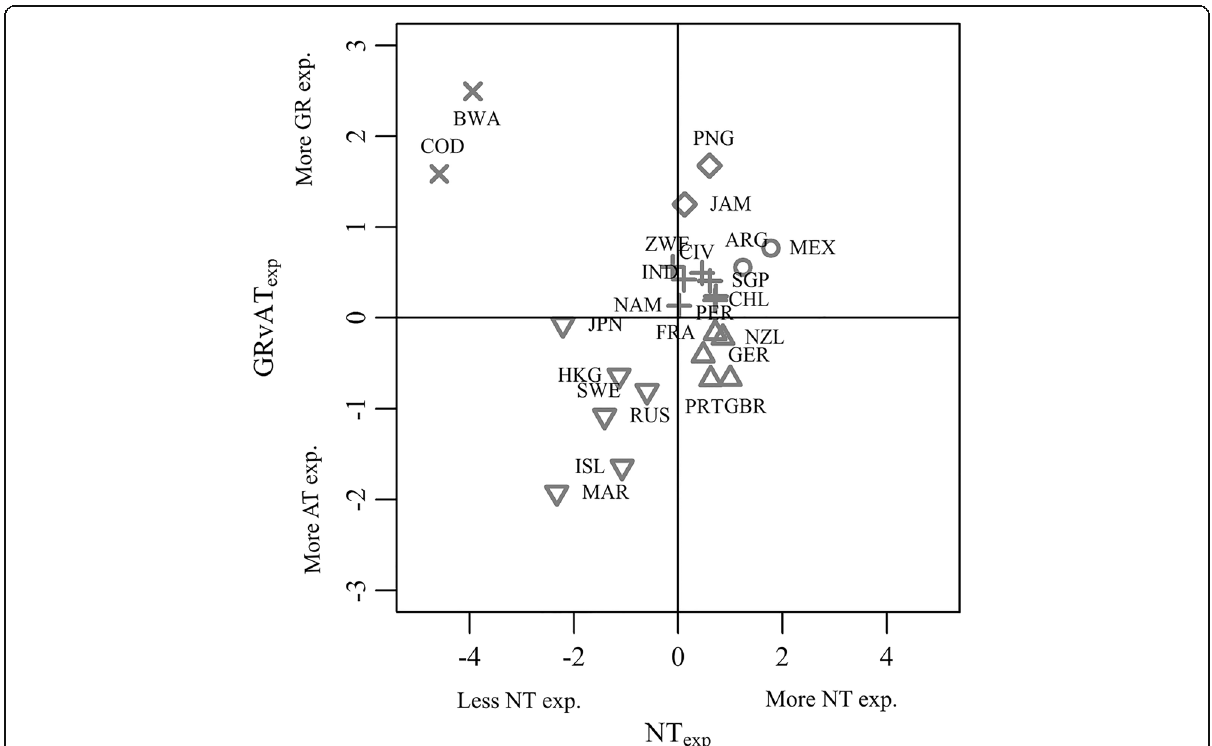
Fig. 2 Mean principal component scores representing the surface experience of players from countries with ≥ 20 respondents. Marker types represent the six k-means clusters. Cluster 1 (white diamond) Japan, Hong Kong, Sweden, Iceland, Russia, Morocco; Cluster 2 (white down- pointing triangle) Zimbabwe, Chile, Ivory Coast, Peru, India, Singapore, Namibia; Cluster 3 (multiplication sign) Papua New Guinea, Jamaica; Cluster 4 (white up-pointing triangle) Mexico, Argentina; Cluster 5 (white circle) Botswana, Democratic republic of Congo and Cluster 6 (plus sign) United